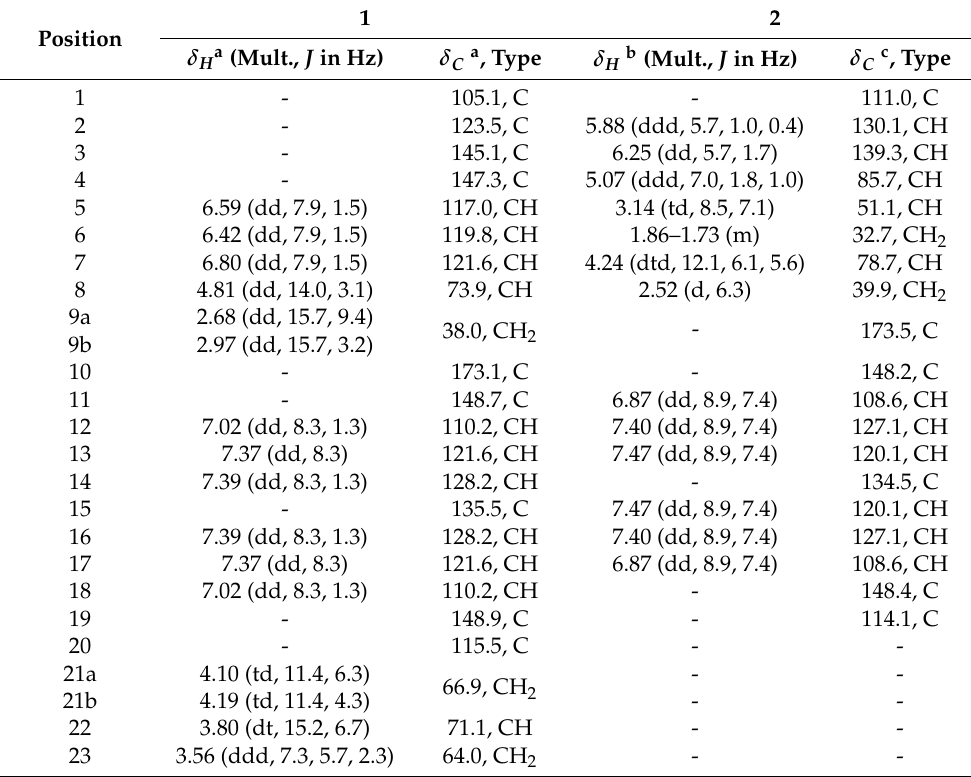
Table 1. NMR Spectroscopic Data of 1 and 2 in MeOH- d 4 .